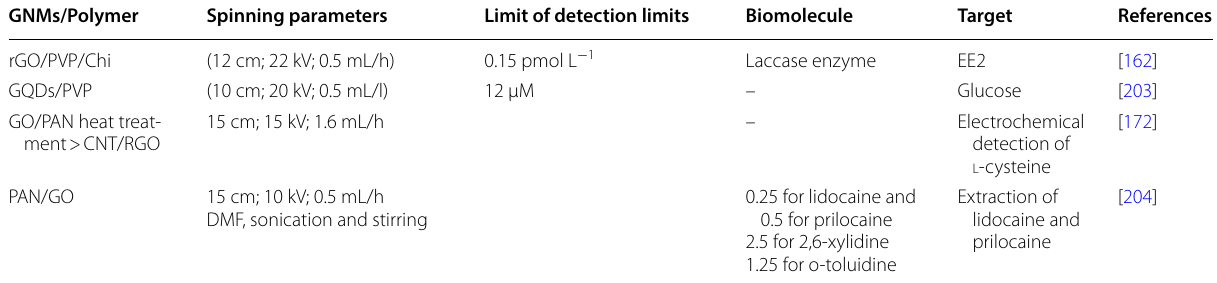
Table 4 Summary of studies on ES GNMs and polymer NF composites for biosensing and sensing applications